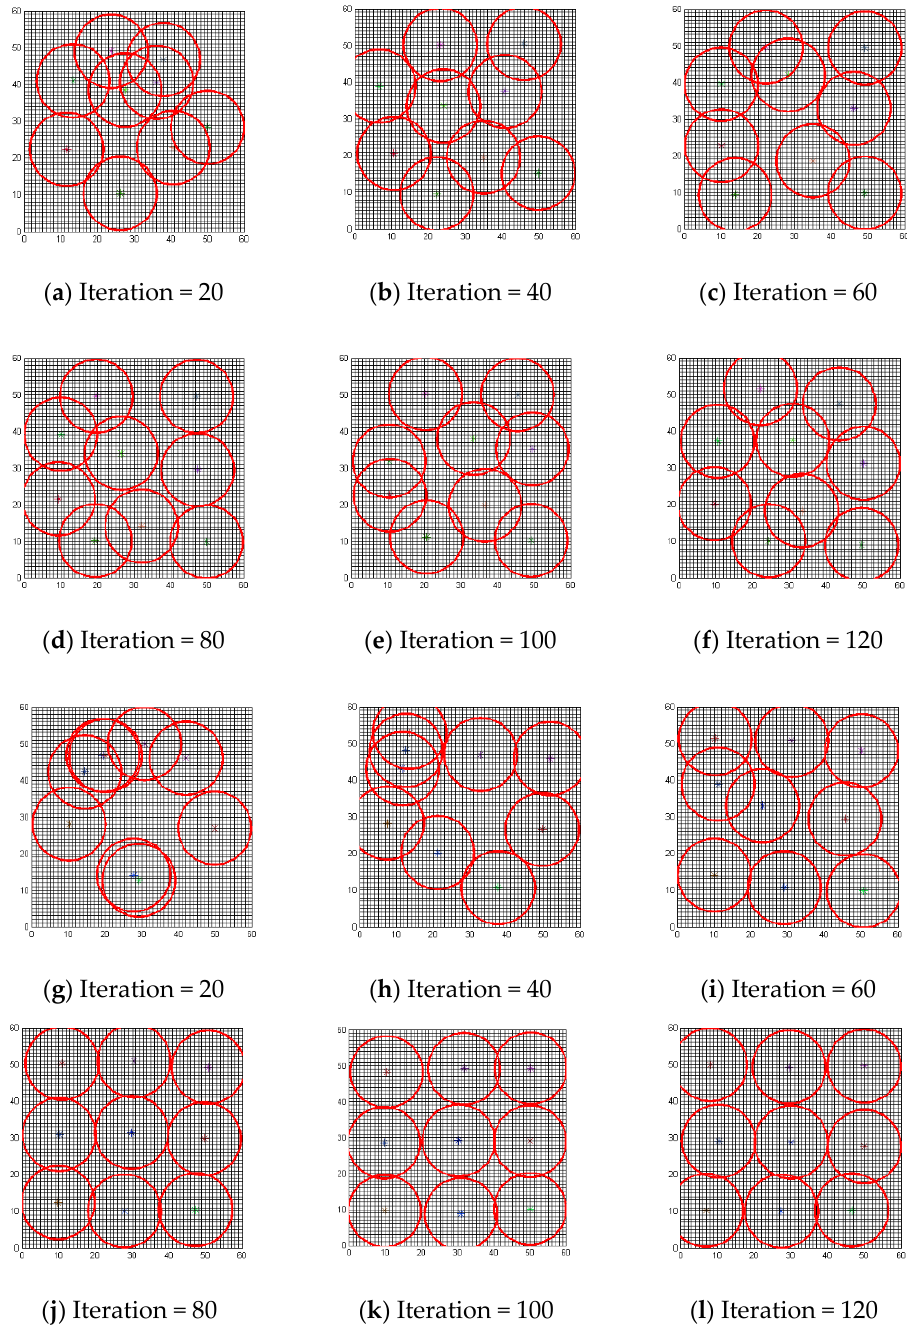
Figure 10. Simulation results for coverage in noise free environment: ( a – f ) The controller in Reference [27]; ( g – l ) A1.